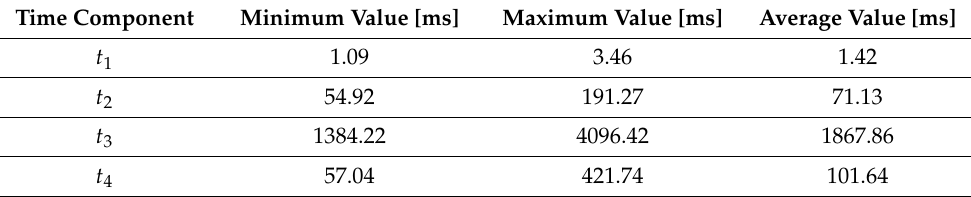
Table 1. Minimum, maximum and average time delay values for each component of the FLA. Time